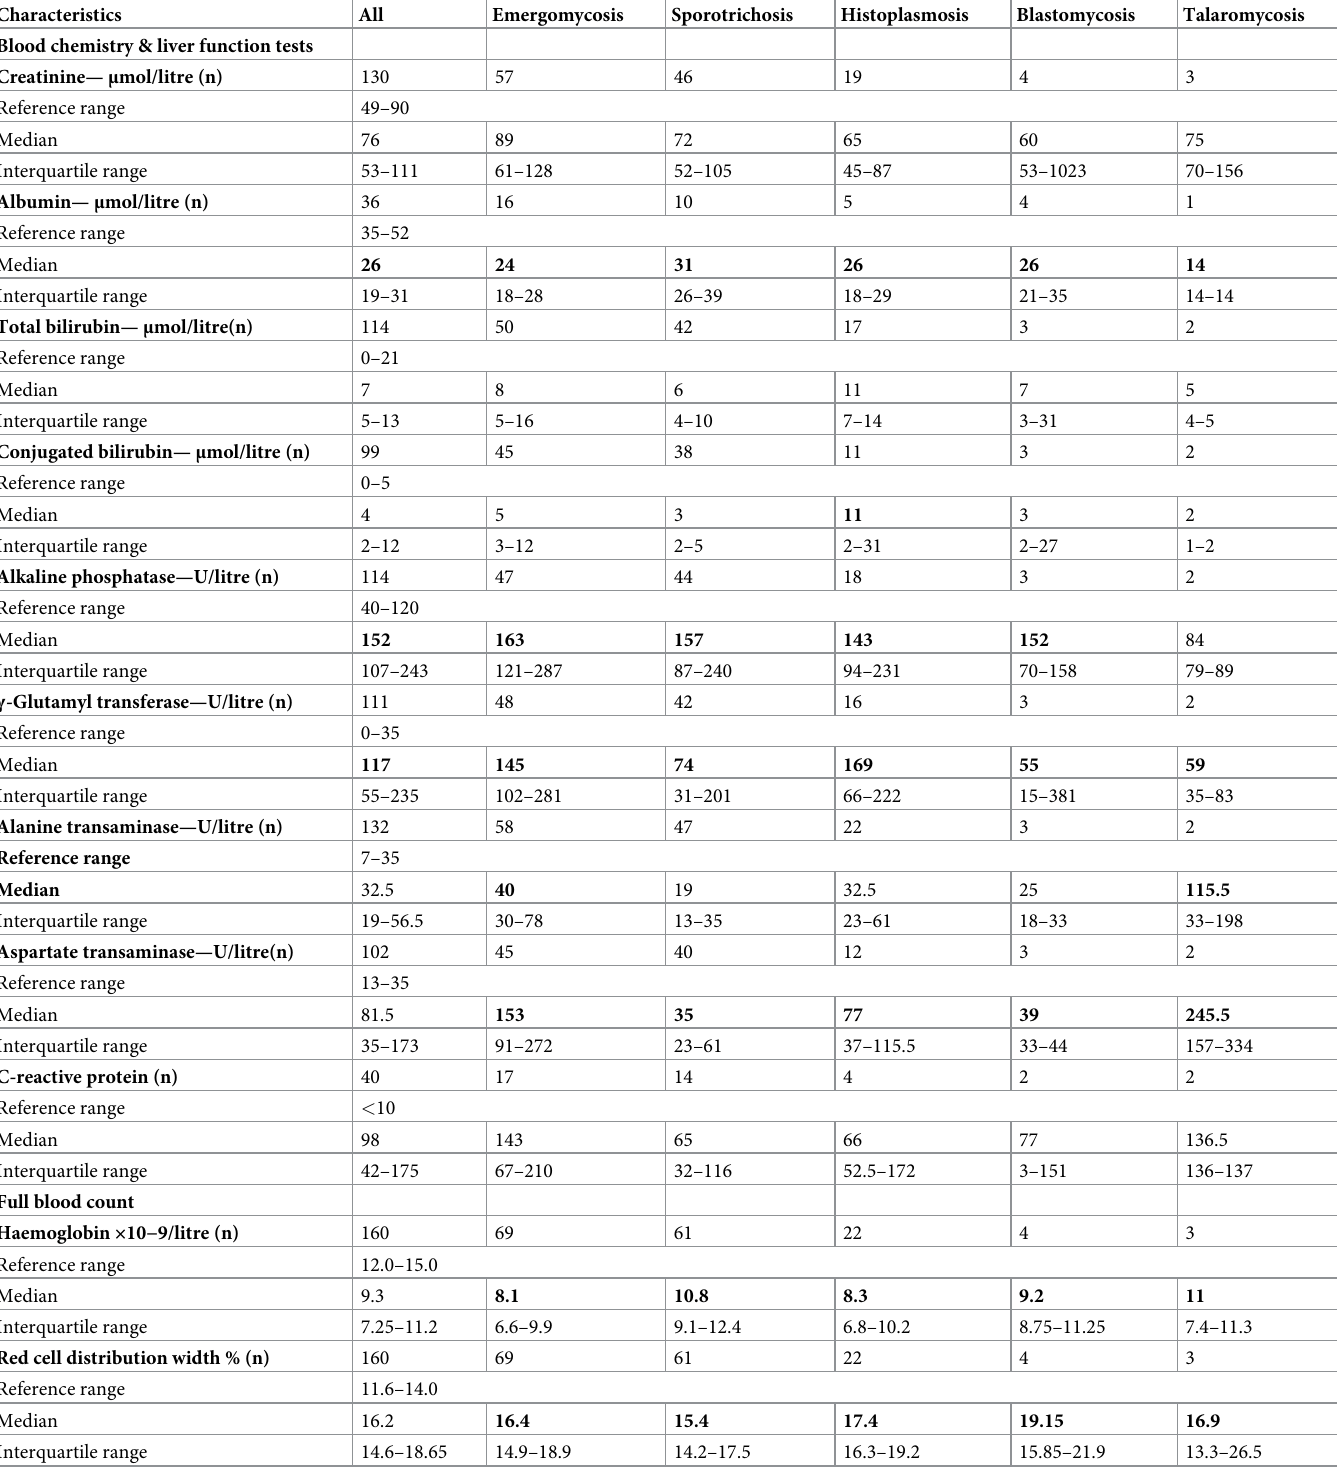
Table 2. Laboratory tests performed 2 weeks before or after the fungal diagnostic test for patients with proven, probable or possible laboratory-diagnosed endemic mycoses in South Africa, 2010–2020.